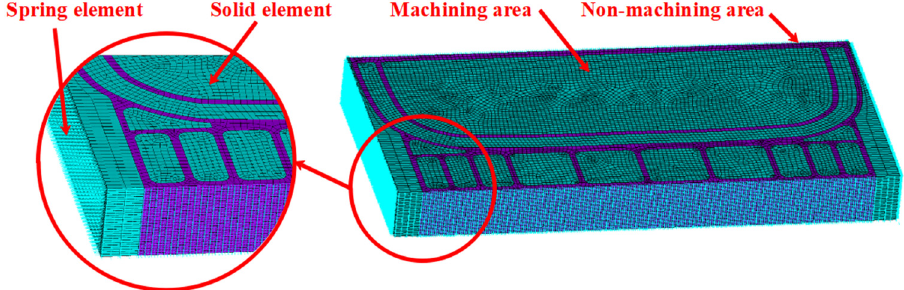
Figure 9: FEM boundary conditions for machining deformation calculation.